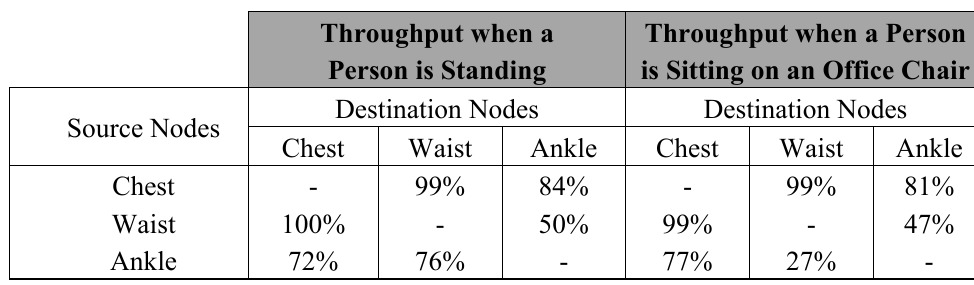
Table 3. Throughput at a 0 dBm Transmit Power